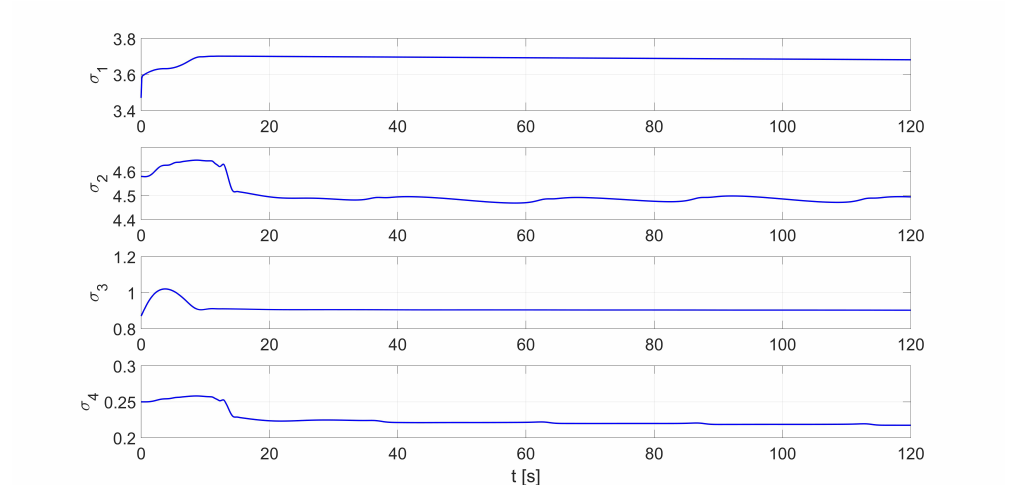
Figure 5. An example of the identification process using the Levenberg-Marguardt-assisted RLS